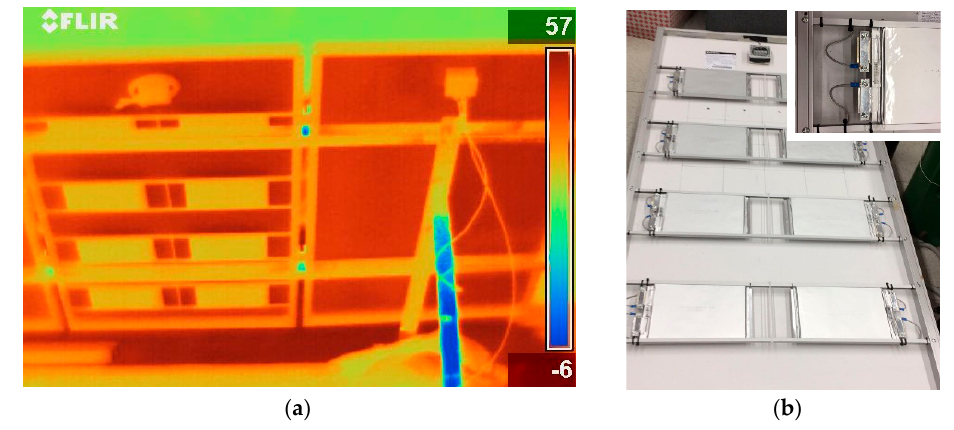
Figure 8. Back side view details of PV modules: ( a ) thermal image with and without battery storage system; ( b ) visual picture of the installed battery and layout.